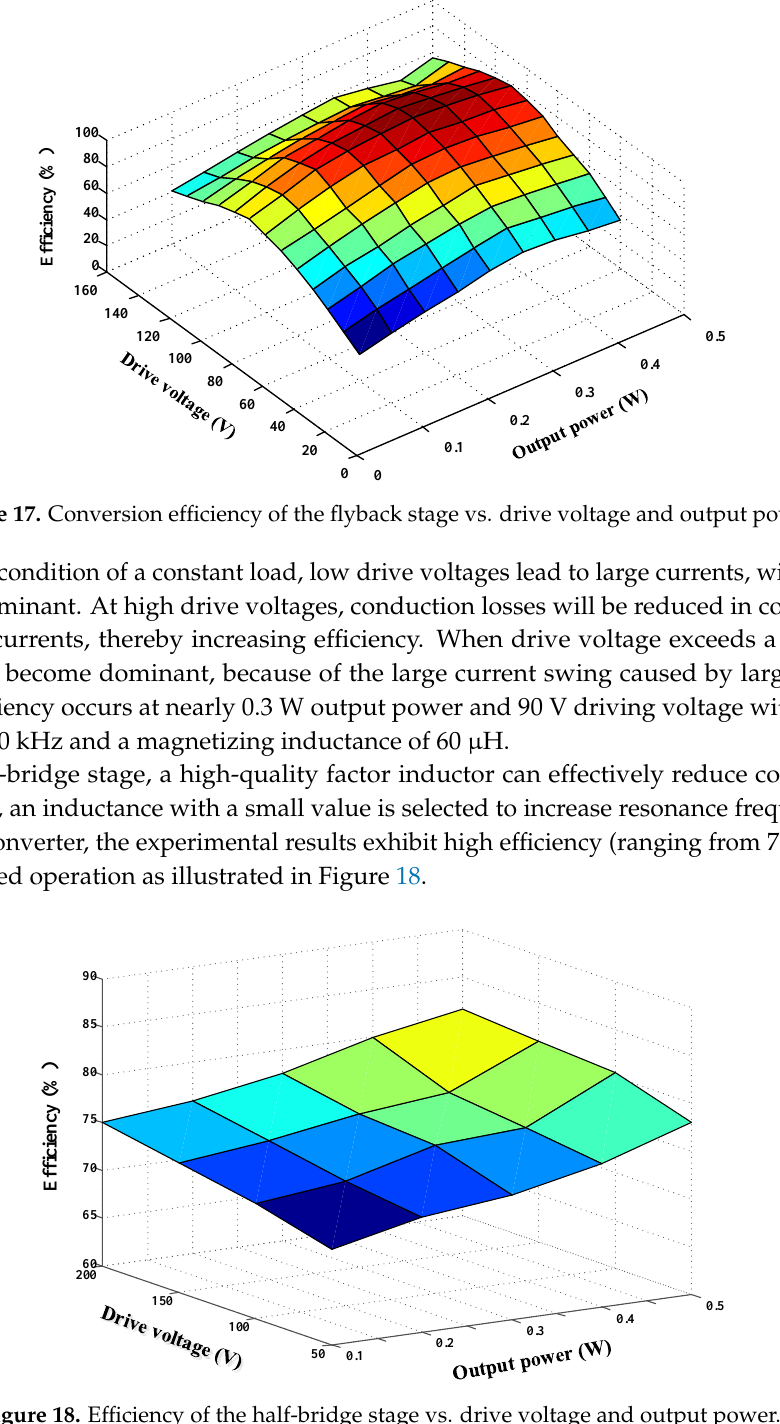
Figure 18. Efficiency of the half-bridge stage vs. drive voltage and output power.